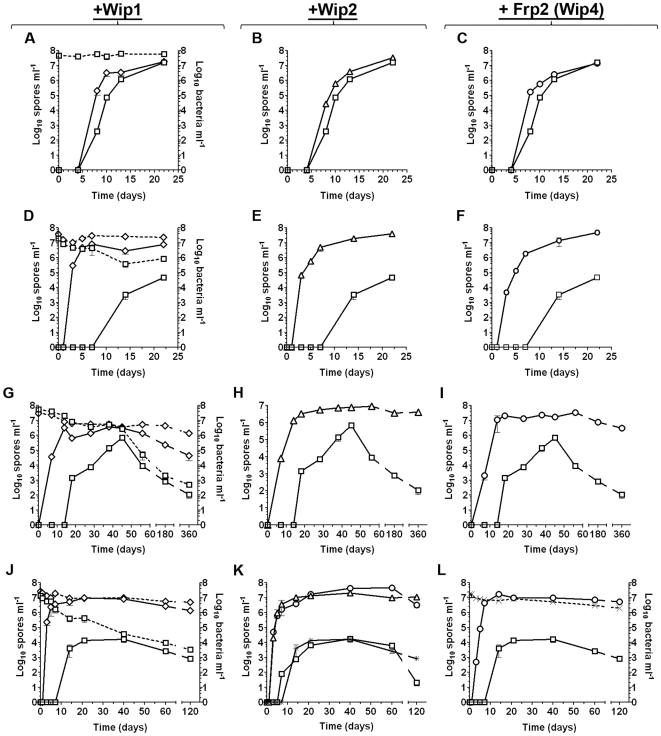
Certain lysogens of B. anthracis sporulate rapidly.Total bacterial cells (vegetative cells and spores; dotted lines) and spores (solid lines) in liquid sporulation cultures were determined over time. Values are mean averages (n = 3) and error bars represent standard deviations. Strains include ΔSterne (open squares) and its lysogens obtained with either Wip1 (open diamonds in A, D, G, and J), Wip2 (open triangles in B, E, H, and K), Frp2 (open circles in C, F, I, and L) or Wip4 (cross-hatches in L). A Wip2-cured lysogen (star symbol in K) and a Wip2-cured lysogen re-infected with Wip2 (open circles in K) are included as well. Sporulating cultures were analyzed under the following conditions: (A–C) LD medium incubated at 30°C with agitation at 75 rpm; (D–F) LD medium incubated at 24°C with agitation at 75 rpm; (G–I) LD medium incubated at 24°C with no agitation; and (J–L) soil medium incubated at 24°C with agitation at 75 rpm.